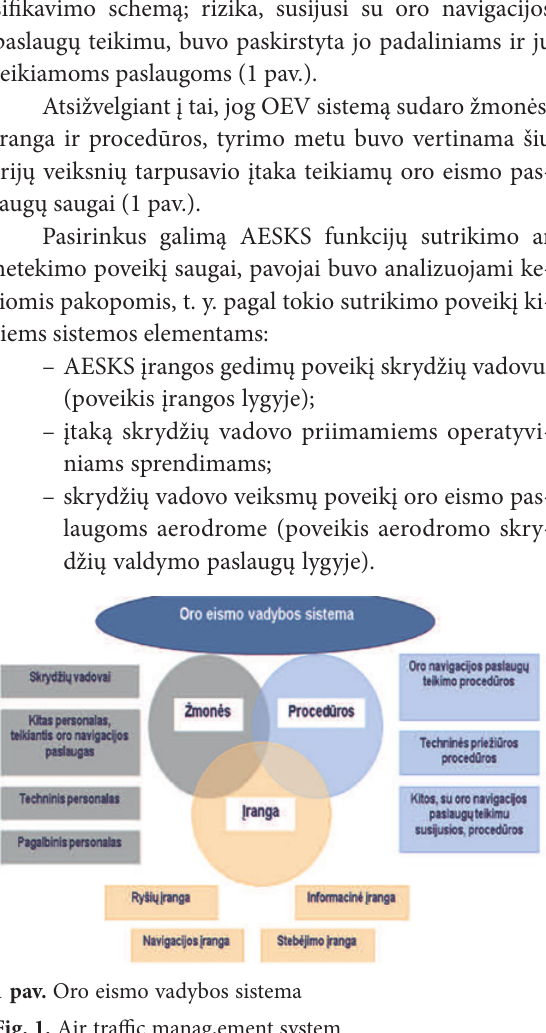
Fig. 1. Air traffic manag,ement system AESKS iš esmės yra skirta tik oro eismo paslaugų teikimui aerodrome, tad oro navigacijos paslaugų